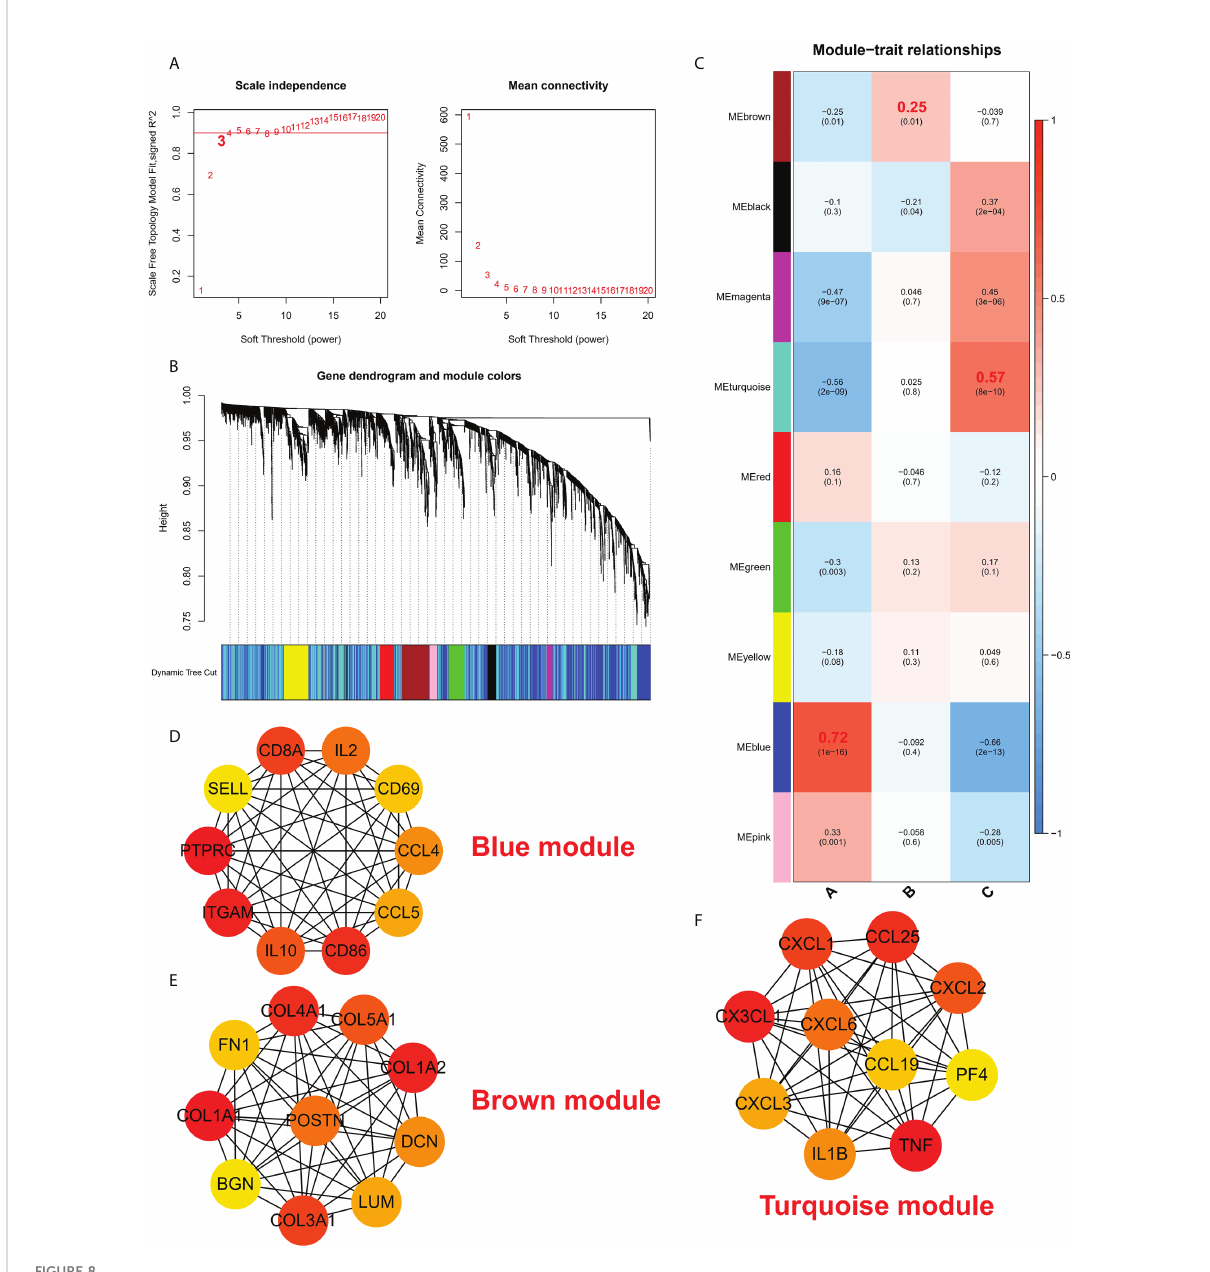
FIGURE 8 (A) Analysis of a scale-free ft index and mean connectivity for different soft-thresholding powers. (B) Gene dendrogram was developed using average linkage hierarchical clustering. The module assignment decided by the Dynamic Tree Cut, in which nine modules were discovered, is displayed in the color row beneath the dendrogram. (C) A heatmap showing how module eigengenes and ICD patterns are correlated. d-f. Hub protein-related PPI networks in the blue module (D) , brown module (E) , and turquoise module (F)